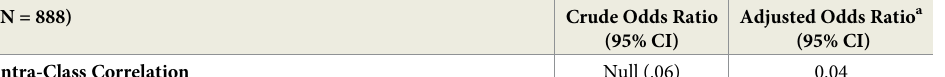
Adjusted model contains all variables in table (N = 869). Total sample size falls due to missing values generated primarily in removing WHZ outliers.